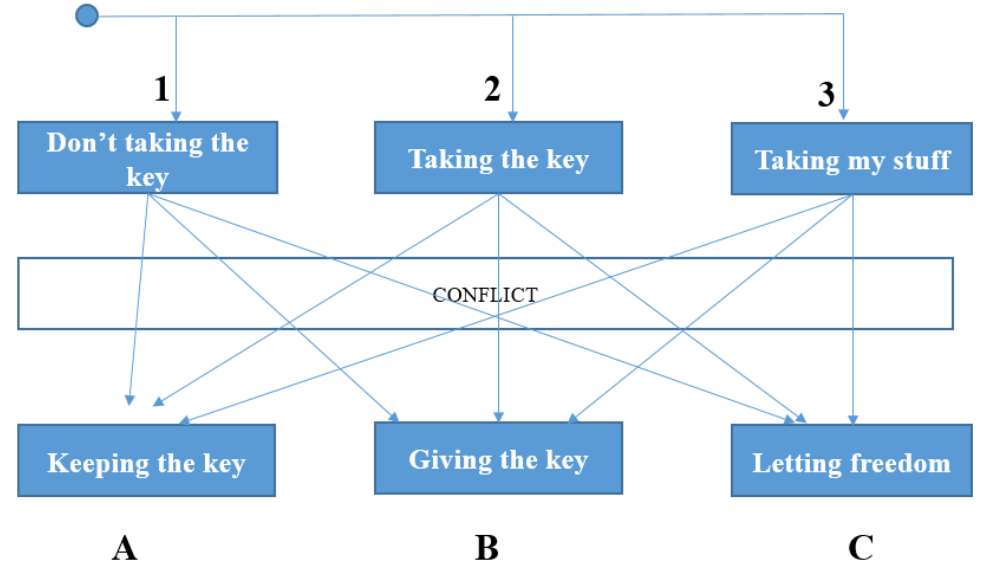
Figure A5. Situation 5—Symptoms. Note. Part I: 1 = doing nothing; 2 = giving orders; 3 = execution.